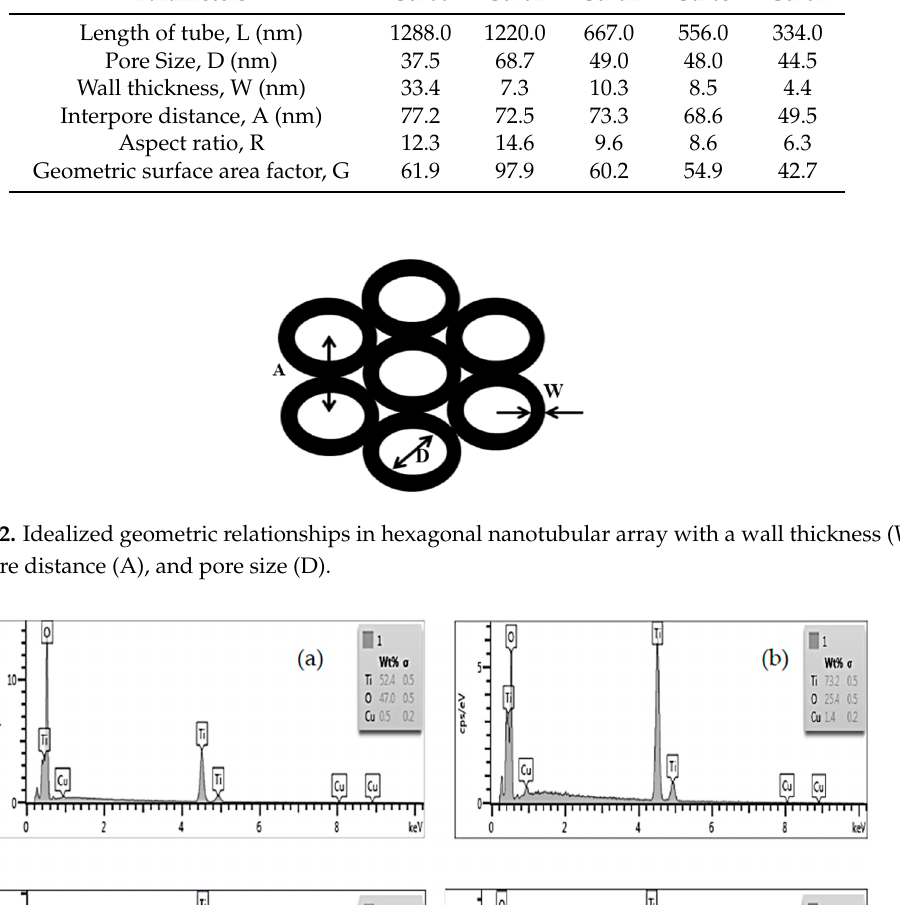
Table 3. Energy dispersive X ‐ ray spectroscopy (EDX) analysis of all samples.